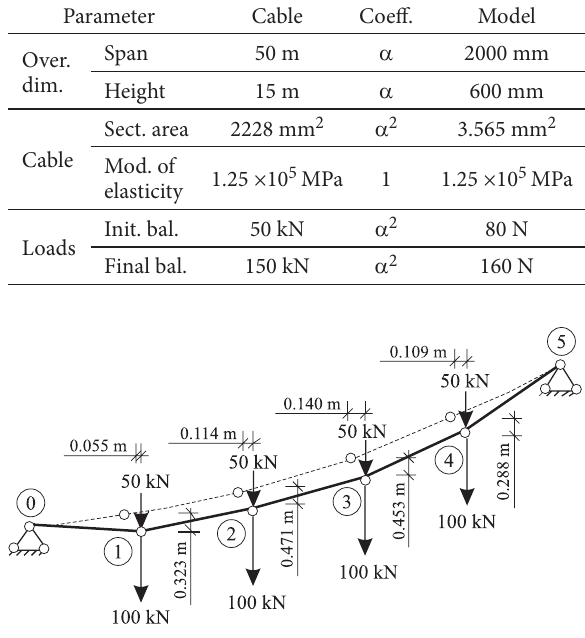
Fig. 5. Displacements of the cable’s nodal points in the final balance using the second simplification (the vertical displacements are increased 5 and the horizontal displacements 10 times in the figure)